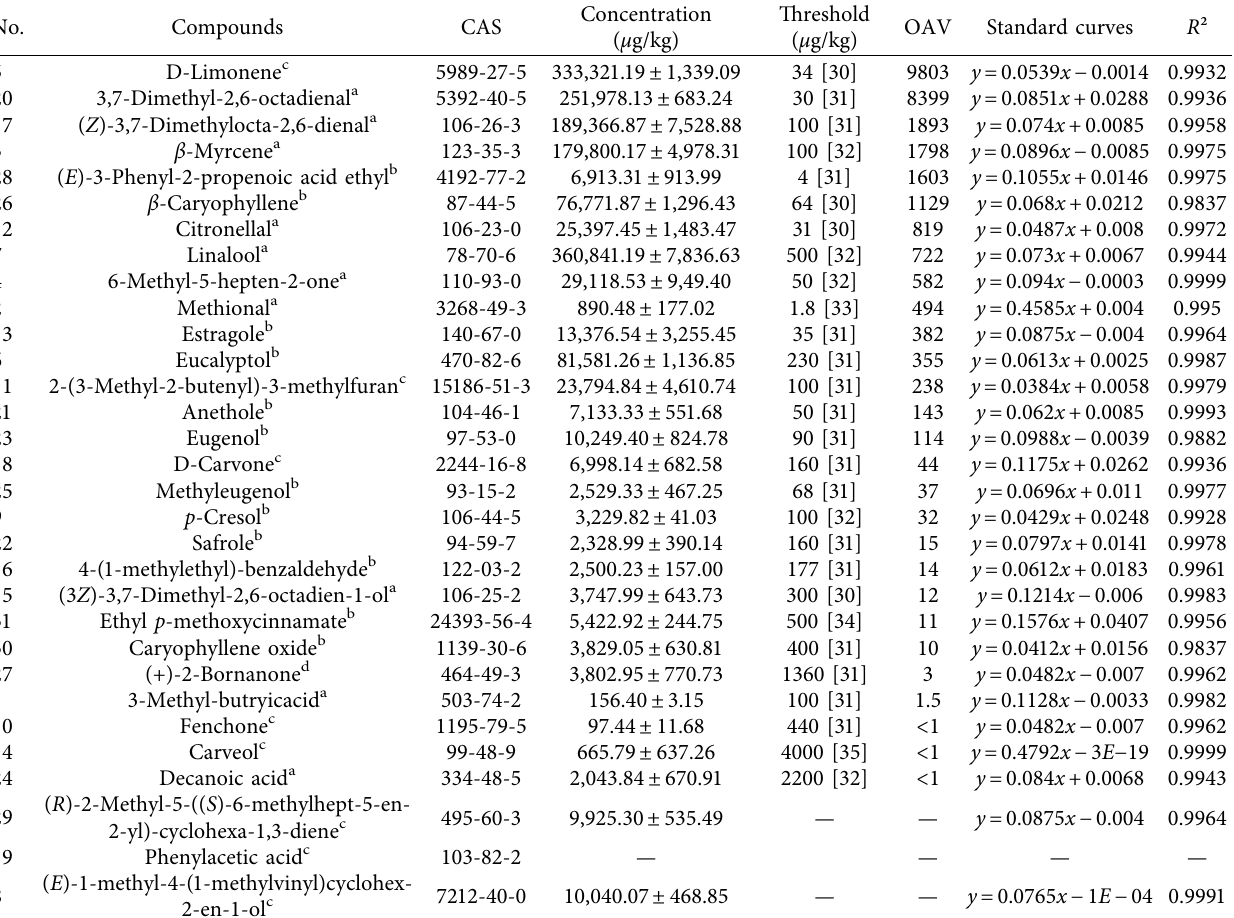
Table 1: Odor activity values (OAVs) of aroma-active compounds (FD � 9) in Litsea pungens Hemsl.